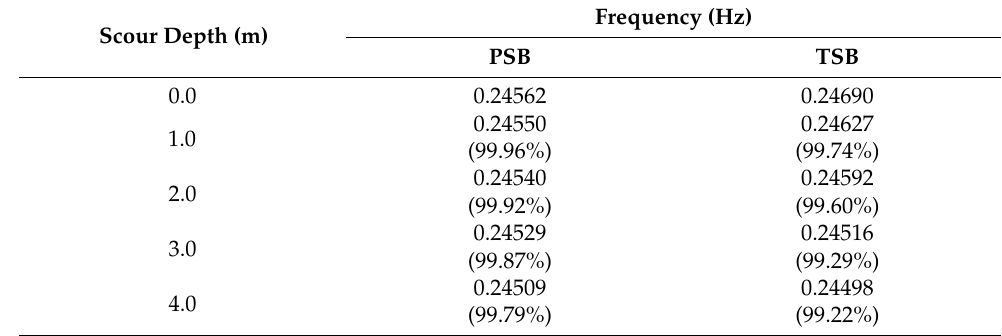
Table 8. First natural frequency results under scour